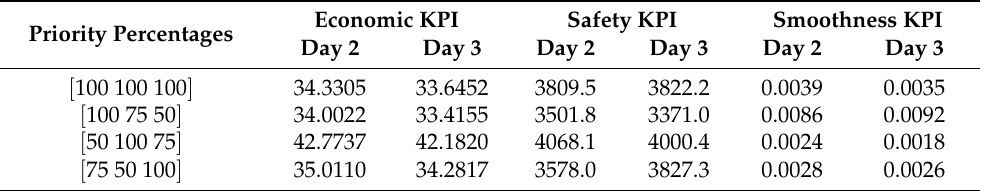
Table 4. KPIs for the DM Strategy using the NWS Method.